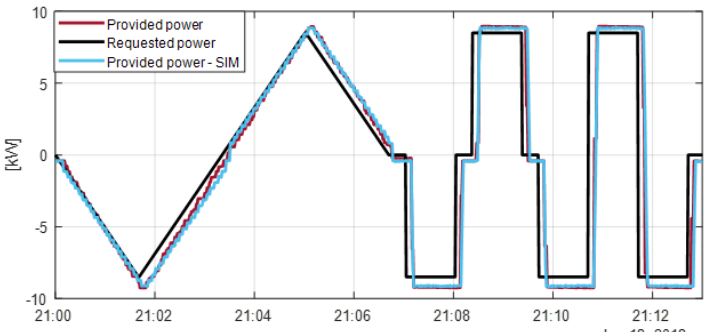
Figure 12. One cycle of the tested and simulated performance assessment